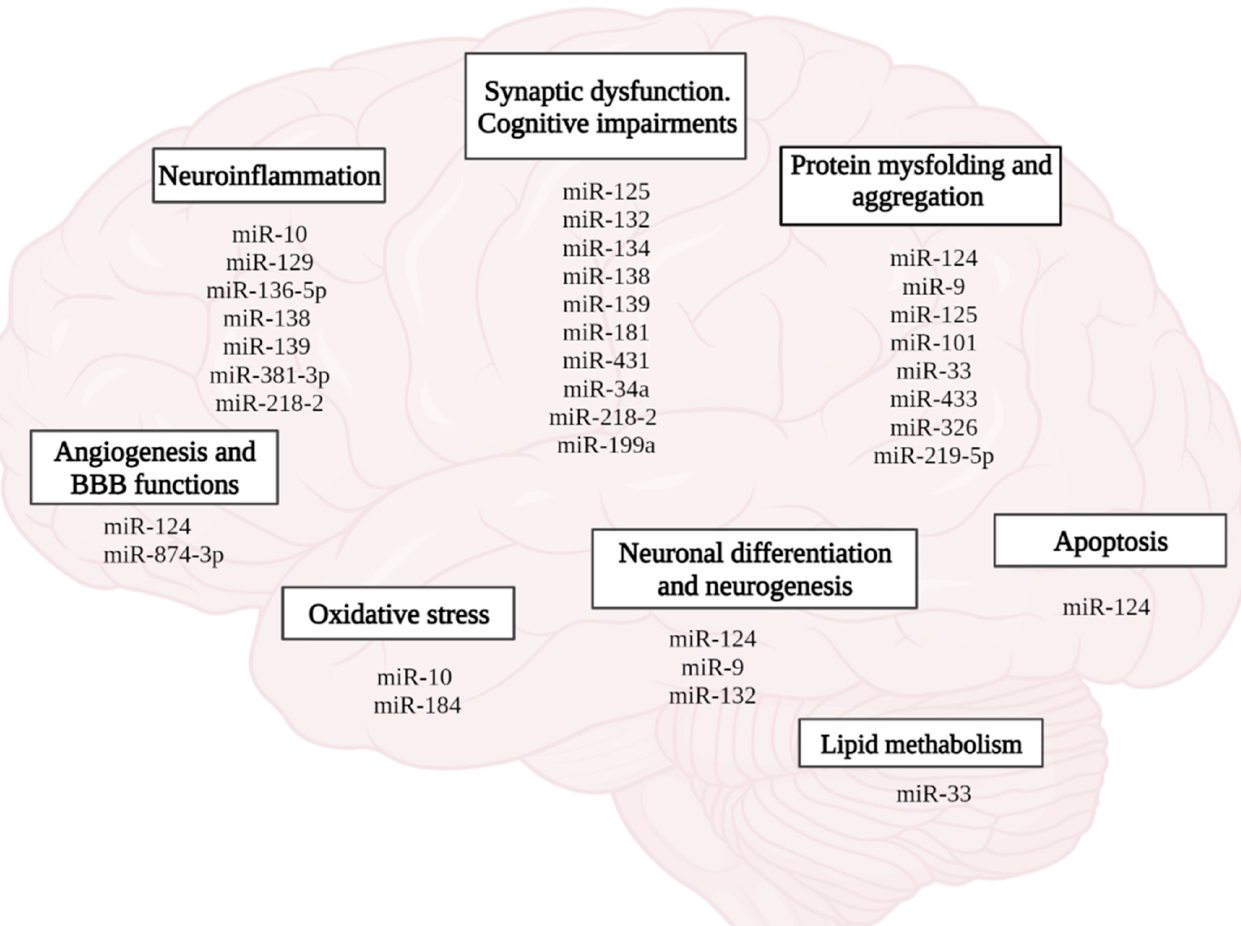
Figure 8. Role of miRNAs in the pathophysiology of AD. (figure created with BioRender.com, accessed on 25 February